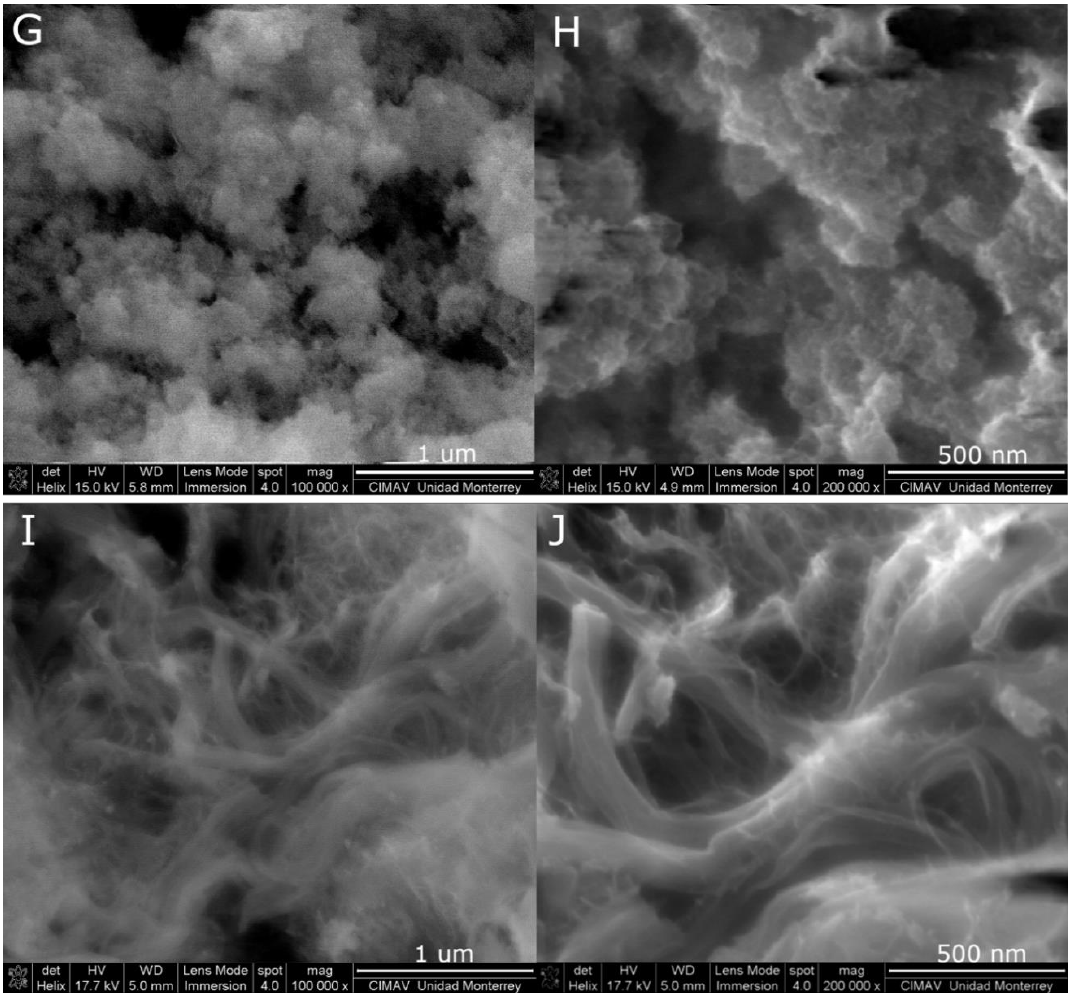
Figure 1. SEM images of Pt-HS ( A , B ), Pt-Co 3 O 4 (s)-HSs: PtAq-CoAq ( C , D ), PtAq-CoOi ( E , F ), PtOi-CoAq ( G , H ), PtOi-CoOi ( I , J ).